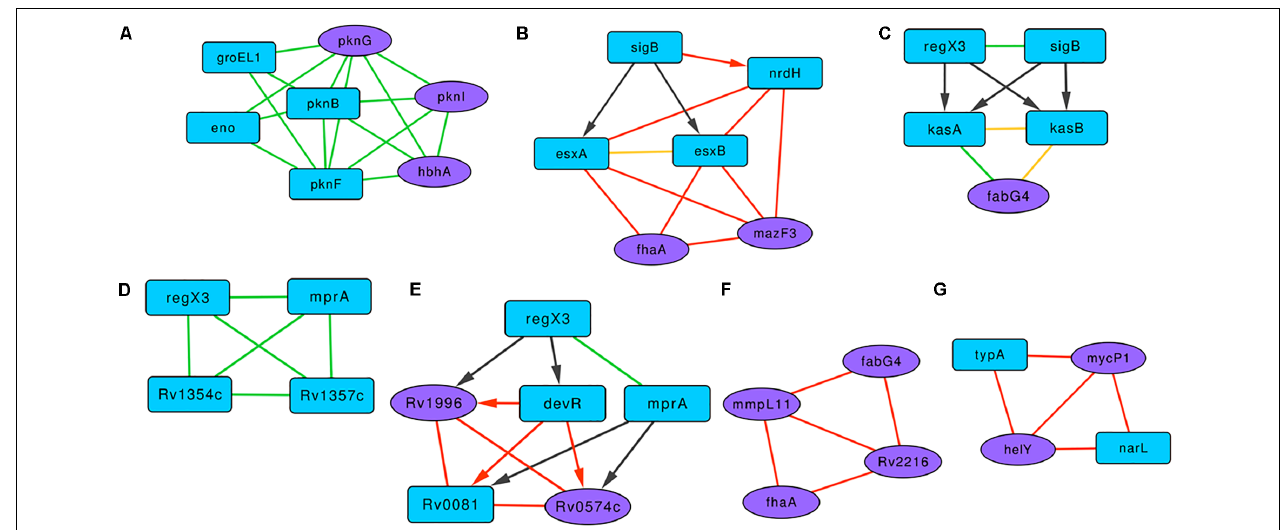
FIGURE 4 | Representative motifs enriched in the Molecular Interaction Network of the BQAPs. (A) A subgraph comprising of protein interactions between serine/threonine protein kinases (STPKs), HbhA, Eno and GroEL1. (B) A subgraph with regulatory interactions of SigB and other proteins with high expression correlations. (C) A bifan motif comprising of RegX3 and SigB. (D) A fully connected protein interaction tetrad between RegX2, MprA, Rv1354c and Rv1357c. (E) A subgraph involving regulatory proteins DevR, Rv0081, MprA and RegX3, and subgraphs showing high expression correlations (F) between MmpL11, FabG4, FhaA and Rv2216, and (G) between MycP1, HelY, NarL and TypA. Blue nodes- predicted proteins, purple nodes - curated proteins, green edges - protein interactions, black edges - gene regulation, red edges - high gene expression correlation, yellow edges - interacting proteins with high gene expression correlation, undirected edge - protein interaction or high gene expression correlation, directed edge - gene